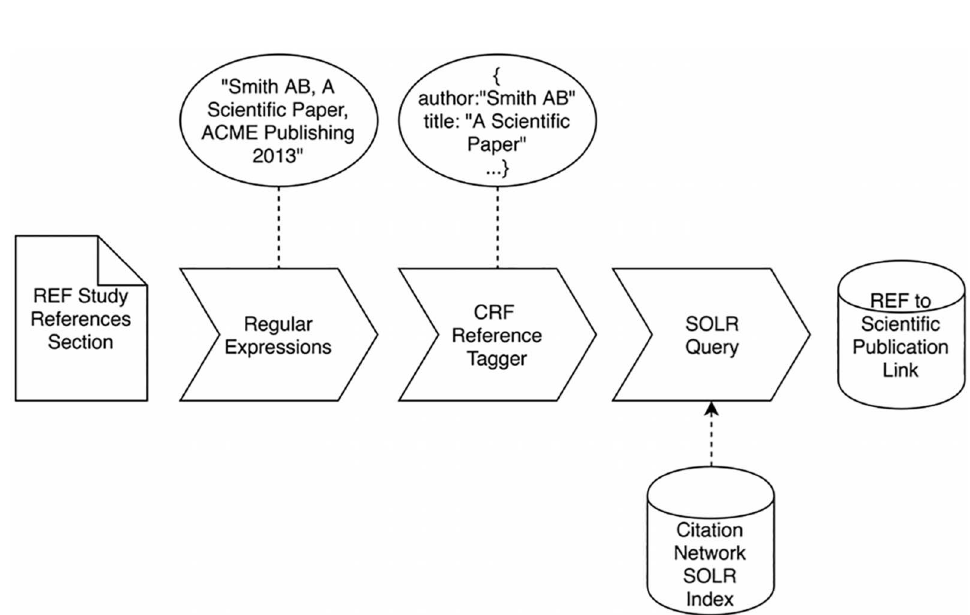
Fig 2. Pipeline process for linking REF studies to publications.